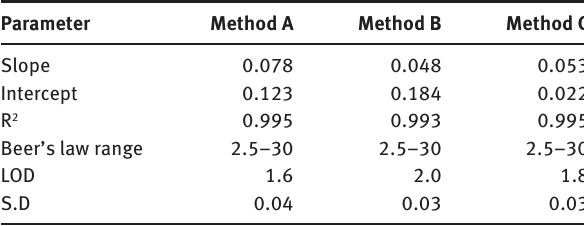
Table 1: Regression data of the developed methods.